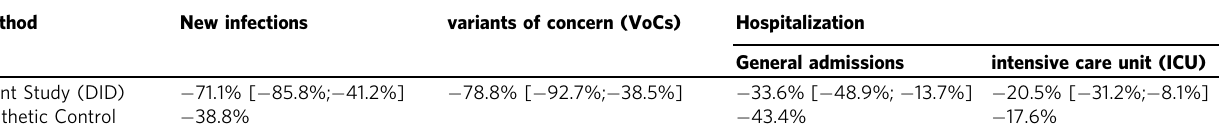
Table 1 Summary table on the percent reduction in new infections as well as hospitalizations using the event-study and the synthetic control